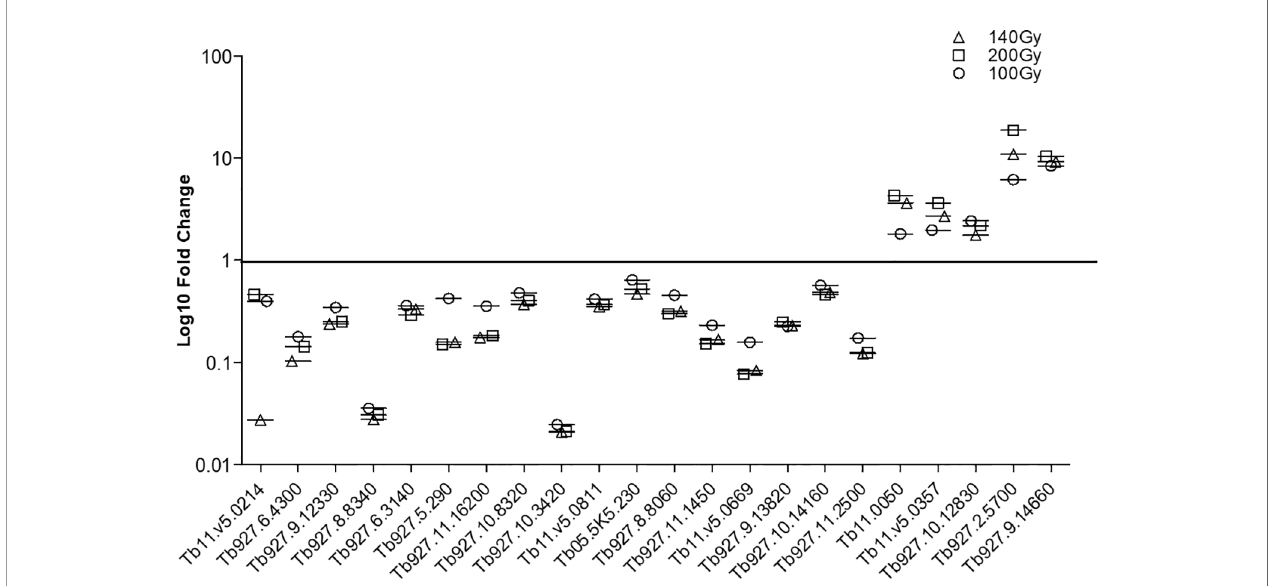
FIGURE 6 | Con fi rmatory qPCR. Twenty-two genes that were either downregulated (17) or upregulated (5) in all three doses at 20h post-irradiation were ampli fi ed using the same RNA samples that had previously been processed using the TrypMS